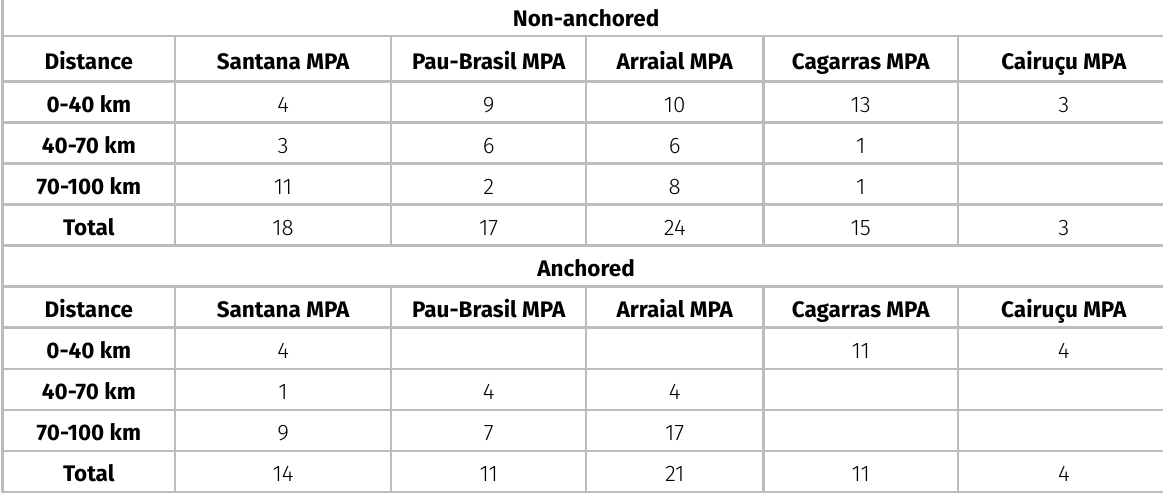
Table IV. Number of non-anchored and anchored oil platforms and drill ships for each analyzed distance and MPA. Distance